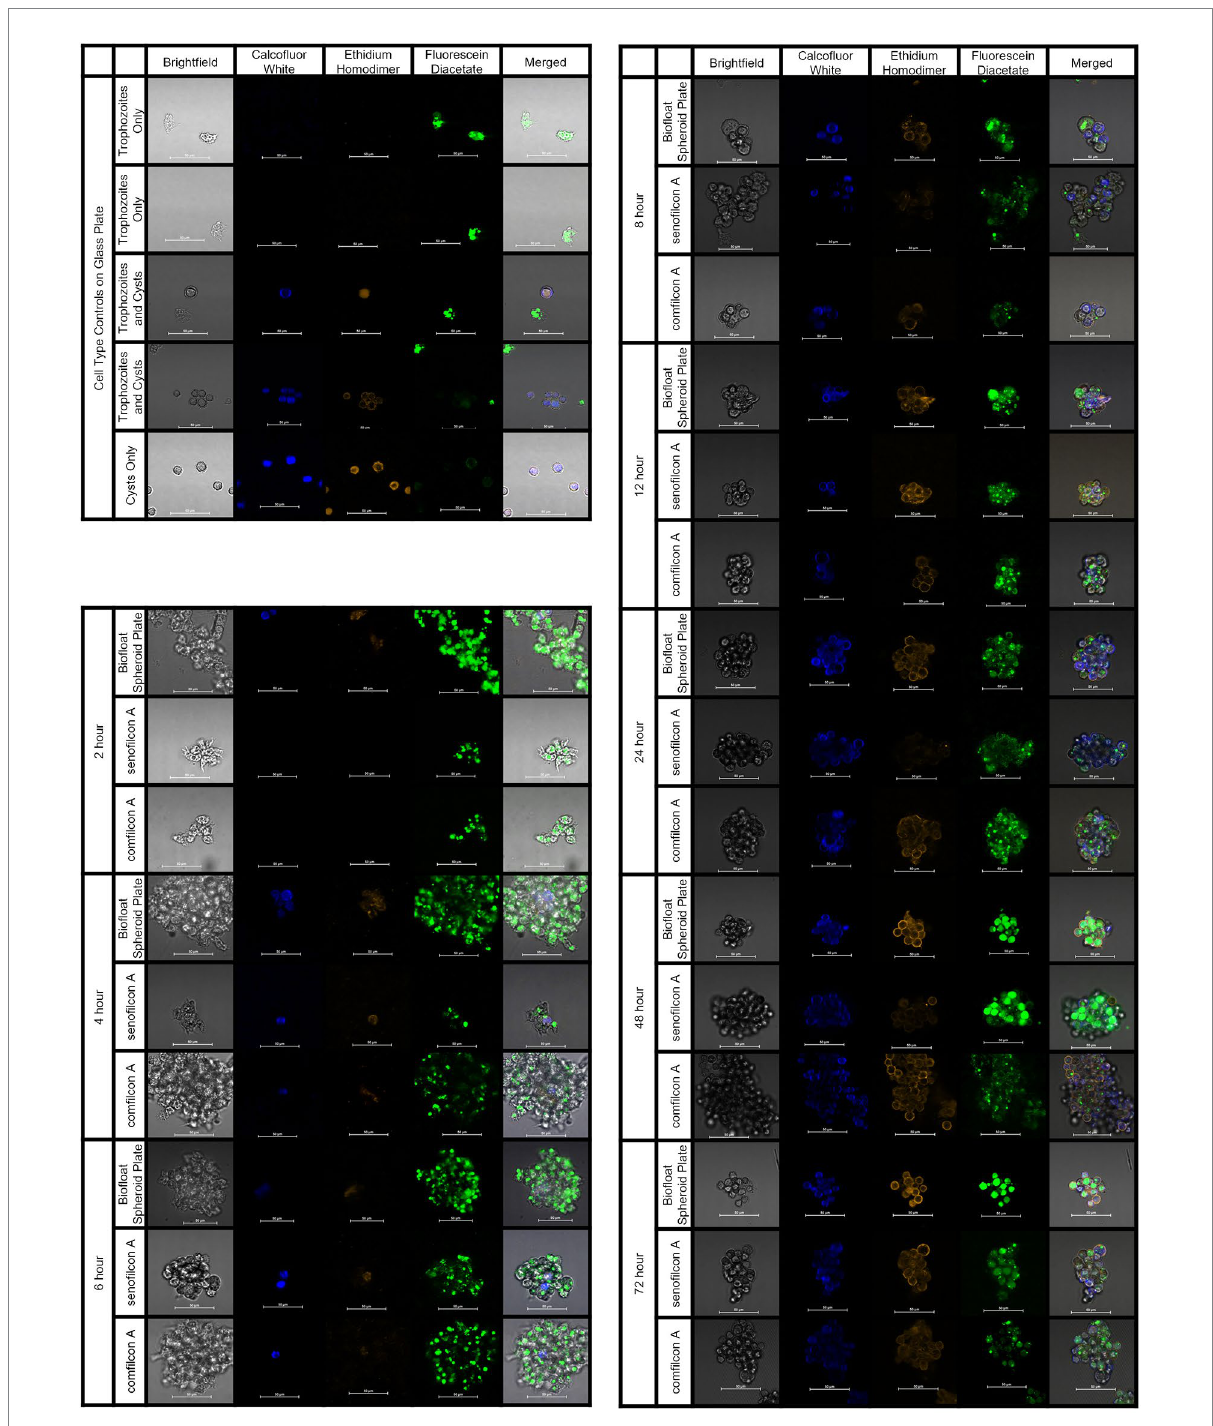
FIGURE 7 Acanthamoeba polyphaga (ATCC 30461) demonstrated encystment at 4 h on all three materials tested, and maintained encystment through 72 h. Controls: Control cells (trophozoites, and cysts pre-made via starvation) were imaged on a glass slide to indicate stain response prior to aggregation experiments. Aggregation: Representative images of fluorescently stained Acanthmoeba spheroids on a spheroid-producing Biofloat plate, senofilcon A, or comfilcon A, without other encystment-inducing substrates. Calcofluor white staining (DAPI filter, blue color) binds to the cellulose of cell walls and indicates cysts. Ethidium homodimer staining (TRITC filter, orange color) binds to nucleic acids and indicates compromised cells or cell death (able to be pentrated by stain and bind to nucleic acids) or presence of extracellular matrix. Fluoroscein diacetate (FITC filer, green color) is a dye that can penetrate trophozoite cell walls and indicates enzymatic activity. All scale bars equal 50 μ m. Eight spheroids were created and imaged for each condition in separate wells and representative images were chosen at